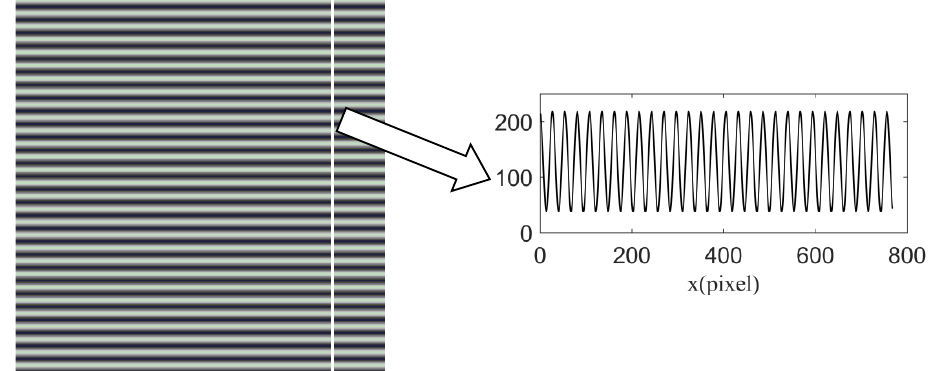
Figure 2. Fringe pattern and intensity value of one column.